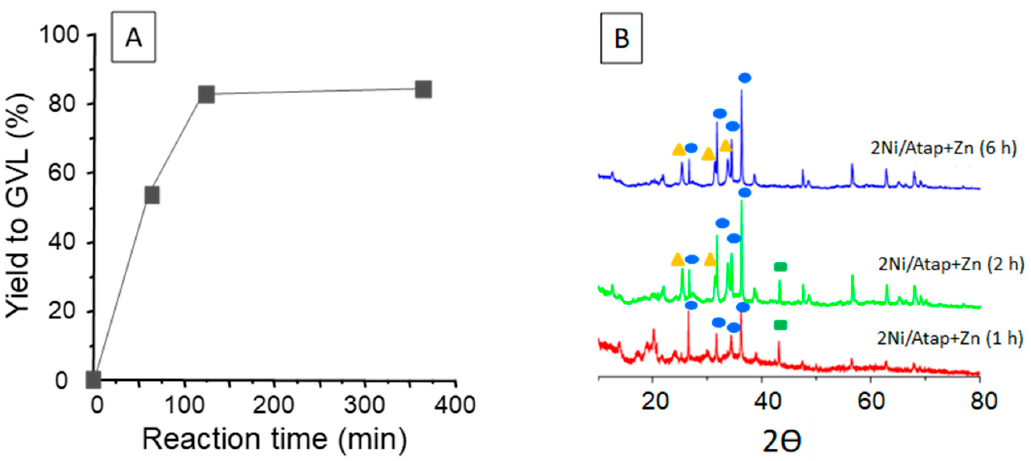
Figure 8. E ff ect of the reaction time on the yield to GVL ( (cid:4) ) using 2Ni / Atap + Zn at 120 ◦ C ( A ) with Figure 8. Effect of the reaction time on the yield to GVL ( ■ ) using 2Ni/Atap + Zn at 120 °C ( A ) with their corresponding XRD after use ( B ). Symbols: ( (cid:4) ) Zn 0 , ( • ) ZnO, ( (cid:78) ) Zn 2 SiO 4 their corresponding XRD after use ( B ). Symbols: ( ■ ) Zn 0 , ( ● ) ZnO, ( ▲ ) Zn 2 SiO 4 .